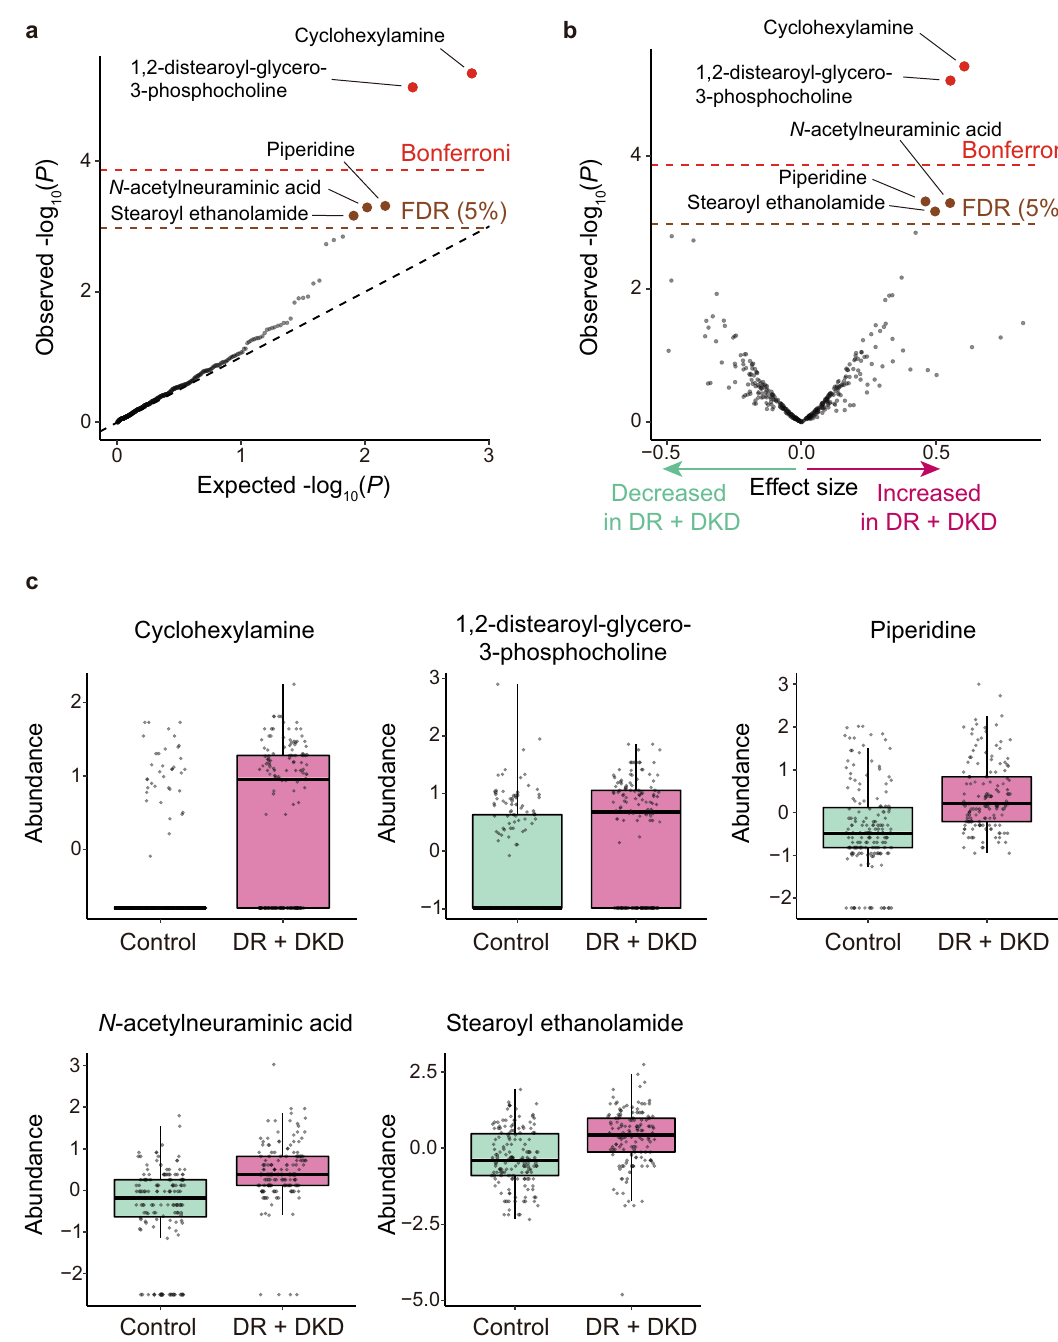
Fig. 1 Results of the case – control association tests for metabolites. a A quantile – quantile plot of the p values in the logistic regression analysis. The x -axis indicates log-transformed expected p values. The y -axis indicates log-transformed observed p values. The diagonal dashed line represents y = x , which corresponds to the null hypothesis. The horizontal red line indicates the Bonferroni-corrected threshold ( α = 0.05), and the brown line indicates the FDR threshold (FDR = 0.05) calculated by the Benjamini-Hochberg procedure. Metabolites with p values less than the Bonferroni thresholds are plotted as red dots, metabolites with p values less than the FDR thresholds are plotted as brown dots, and other metabolites are plotted as black dots. b A volcano plot. The x -axis indicates effect sizes in logistic regression. The y -axis, horizontal lines, and dot colors are the same as in a . c Boxplots for the fi ve metabolites which were signi fi cantly associated with the complications of T2D. Boxplots indicate the median values (center lines) and IQR (box edges), with the whiskers extending to the most extreme points within the range between (lower quantile − [1.5 × IQR]) and (upper quantile + [1.5 × IQR]). The number of samples used for the analysis is N DR + DKD = 141 and N control = 159. DKD, diabetic kidney disease; DR diabetic retinopathy; FDR, false discovery ratio; IQR, interquartile ranges; T2D, type 2